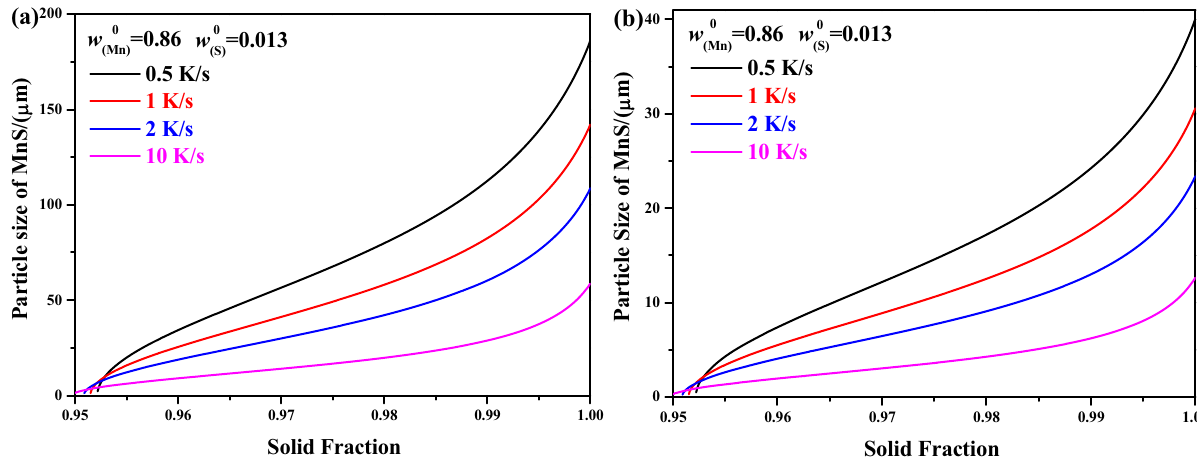
Figure 3: Relationship between the particle size of MnS and solid fraction at different cooling rates ( 0.5, 1, 2, and 10 K/s ) . ( a ) Obtained with time τ . ( b ) Obtained with time t .